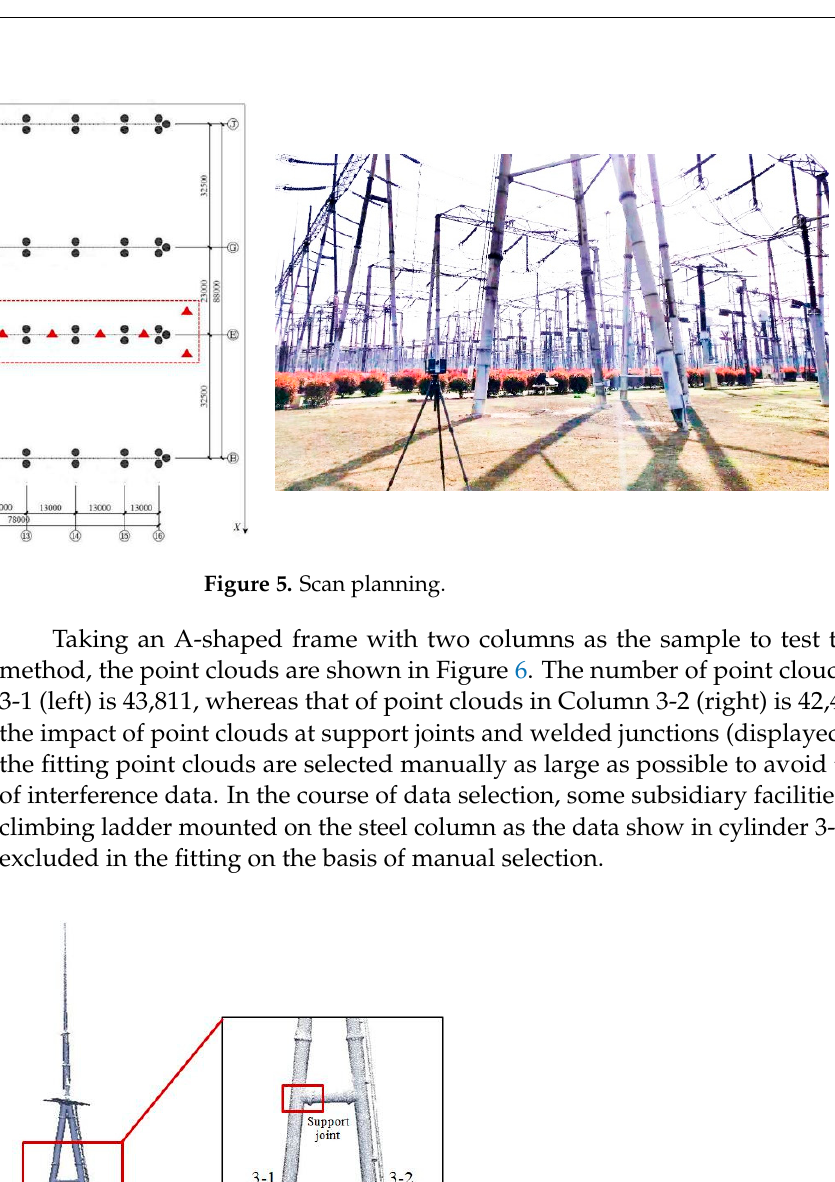
Figure 6. Point clouds of an A-shaped frame.